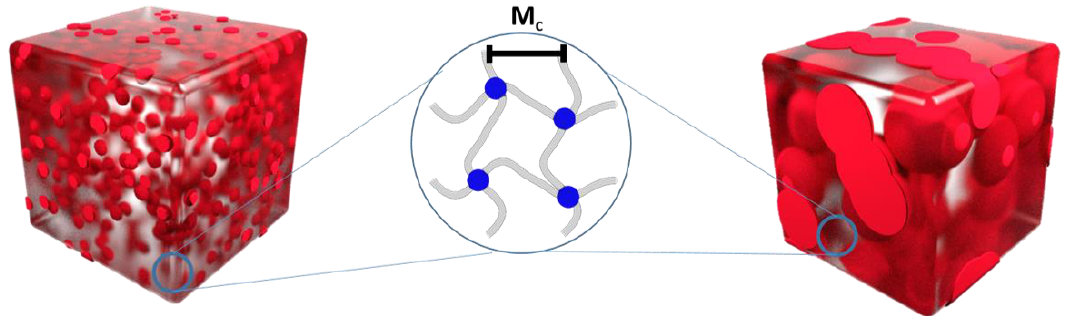
Figure 1. Schematic representation of networks containing different amounts of non-crosslinked PCL leading to different morphologies containing open or closed compartments defining the accessible reptation volume for the macromolecules (red domains). Network structure on the macromolecular level indicating a similar average chain length (M c ) between netpoints.